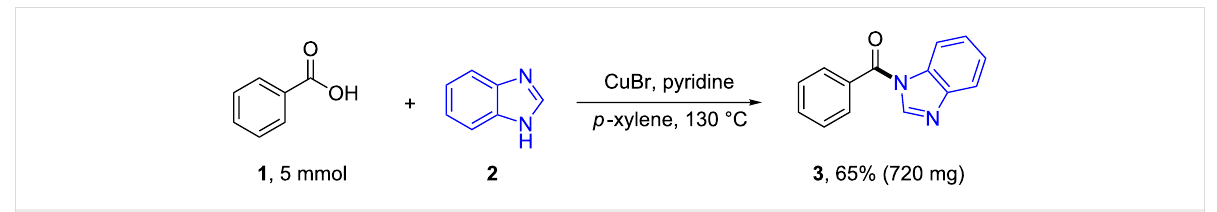
Scheme 6: Preparative scale of the reaction.